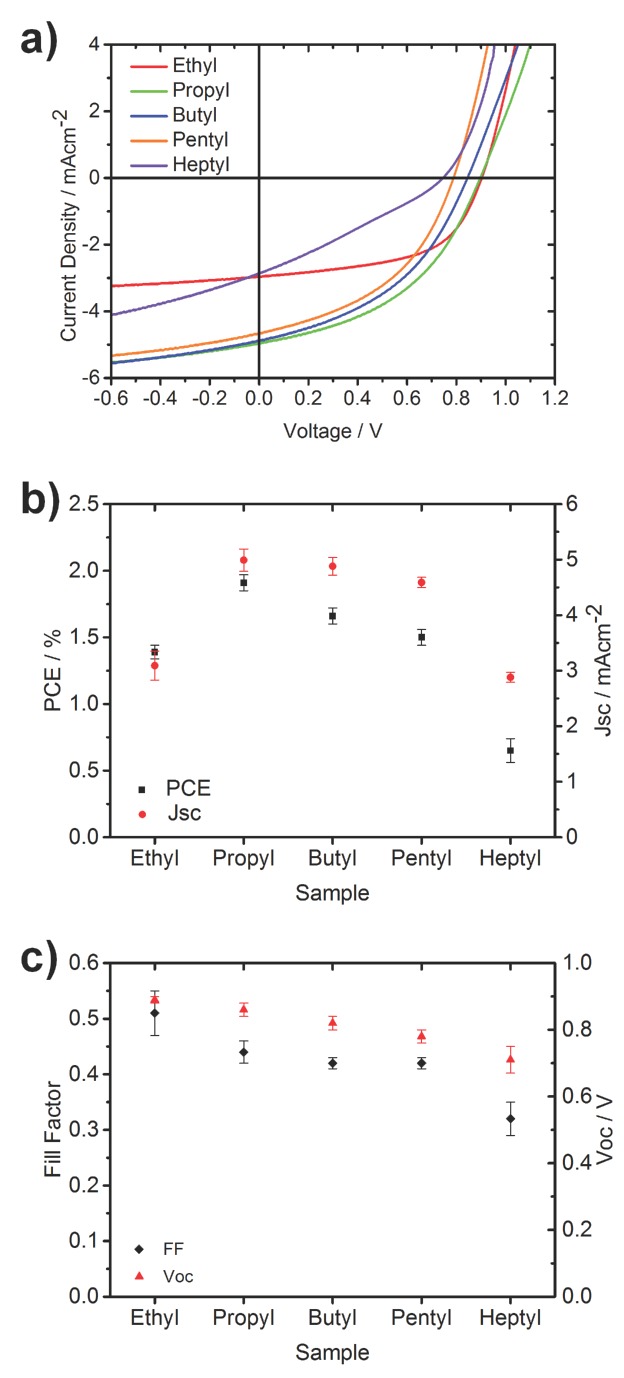
a) Current–voltage characteristics of typical devices, b) average power conversion efficiencies (PCE) and short circuit currents (Jsc) of an average of the 10 devices with the highest PCE, c) average fill factors (FF) and open circuit voltages (Voc) of the same 10 most efficient devices.